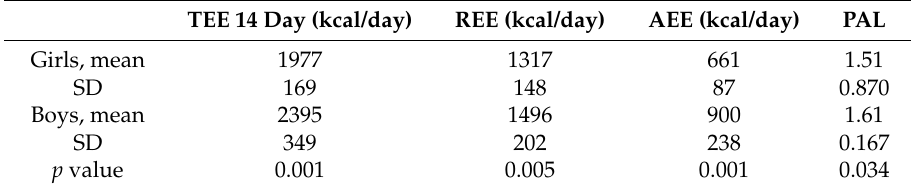
Table 2. Total energy expenditure (TEE) based on 14 days data collection, predicted resting energy expenditure (REE), estimated activity energy expenditure (AEE) expressed as kilocalories (kcal) per day, and calculated physical activity level (PAL; TEE/REE) for 17 boys and 18 girls. TEE 14 Day (kcal/day) REE (kcal/day) AEE